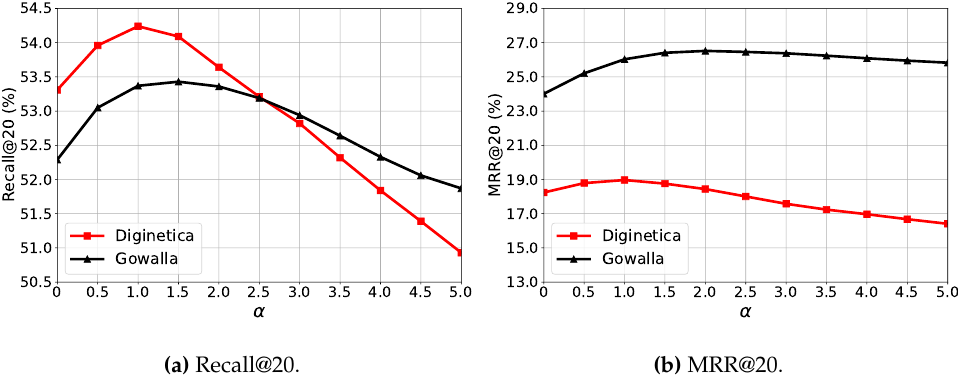
Figure 2. Model performance with different α in the corrective margin